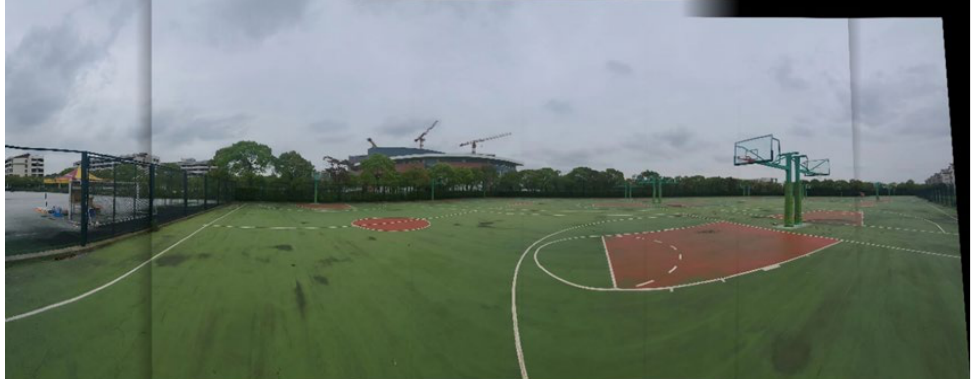
Figure 7. Results obtained with the left-to-right approach.